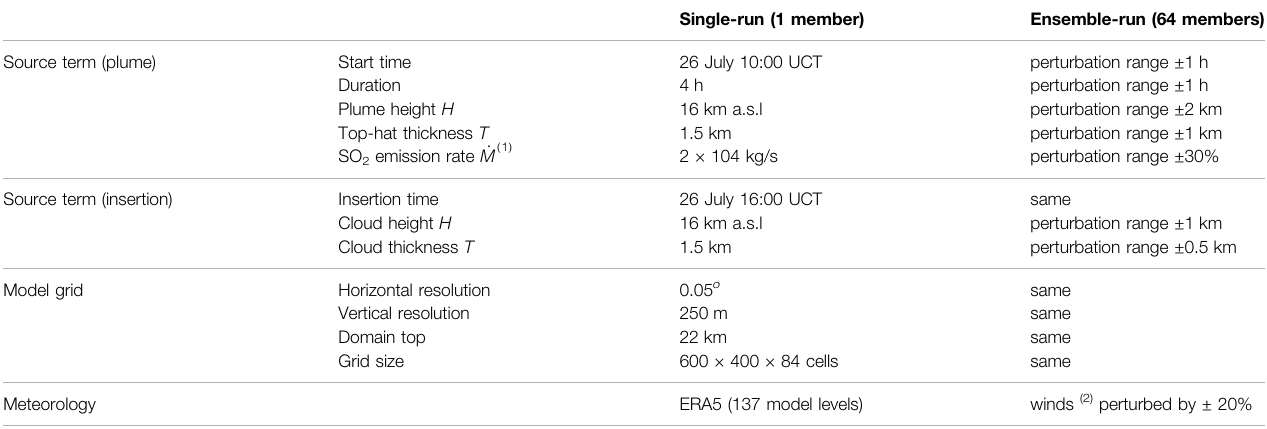
TABLE 4 | Model setup for the July 26, 2018 single-run and ensemble-based (64 members) Ambae SO 2